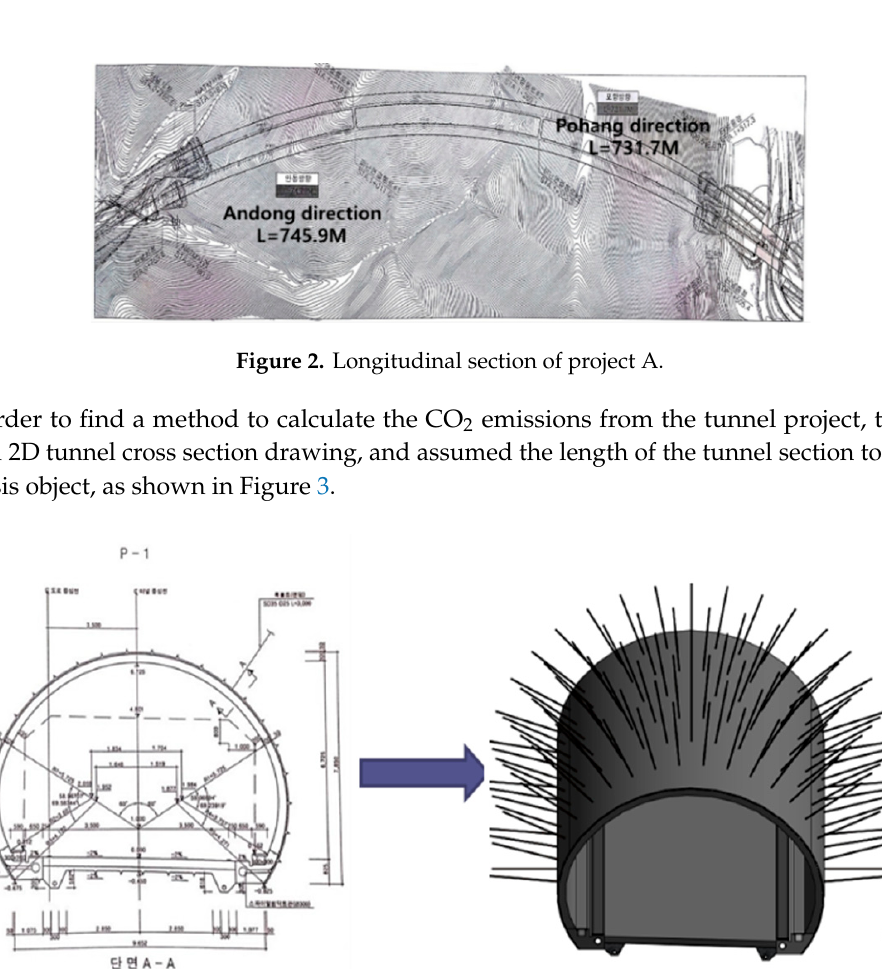
Figure 3. 2D tunnel cross on drawings ( left ), 3D tunnel model section ( right ).